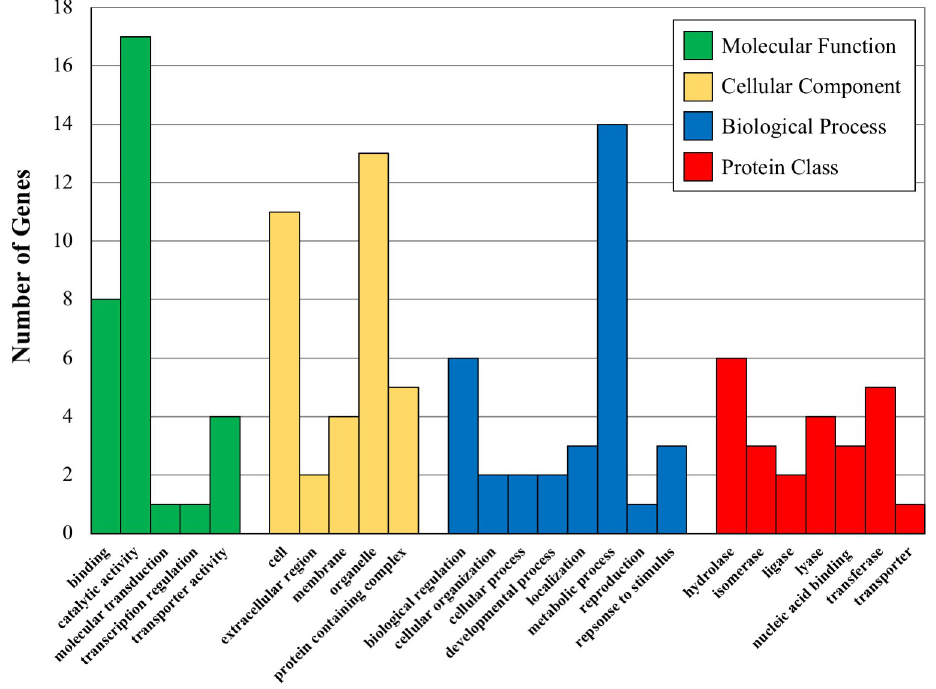
Fig 2. Graph of chromosomal location and SNP significance. Chromosome number is listed at the top. Below the dotted line are the top 5% most significant SNPs. The trait categories are listed in the box at the lower left along with their respective symbol colors. Chemical categories are: ‘cbd’, ‘thc’, ‘cbn’, and ‘ratio’. Non-chemical categories are: ‘I/S’ (the ratio if ‘indica’ to ‘sativa’), ‘taste’, ‘effect’, ‘medical’, and ‘grow’. At the bottom we tally the number of SNPs that have p values in the top 5% most significant SNPs (top value: chemical categories, bottom value: non-chemical categories).